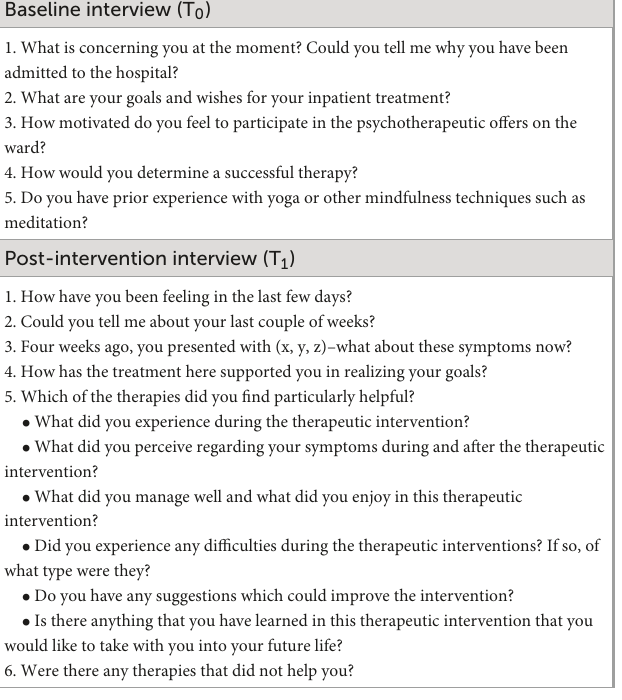
TABLE 1 Semi-structured interview guide. Baseline interview (T 0 )